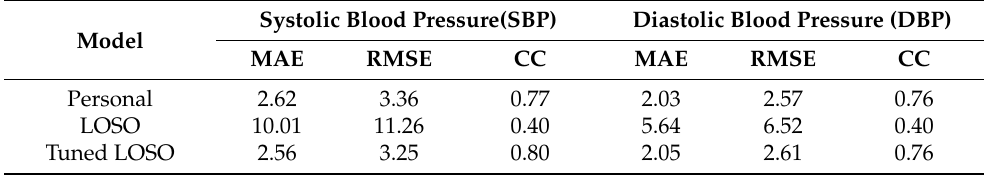
Table 4. Mean values of MAE, RMSE, and CC for each